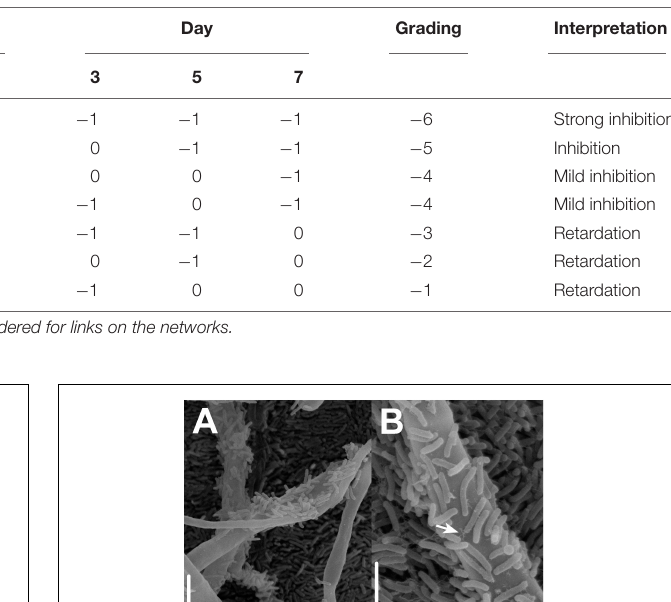
TABLE 1 | Grading of repressions and inductions of growth used to determine the strength of links on the interaction networks, where 1 means that the size of the colony was significantly larger than the control, − 1 means it was significantly smaller, and 0 means no significant change. Day Grading